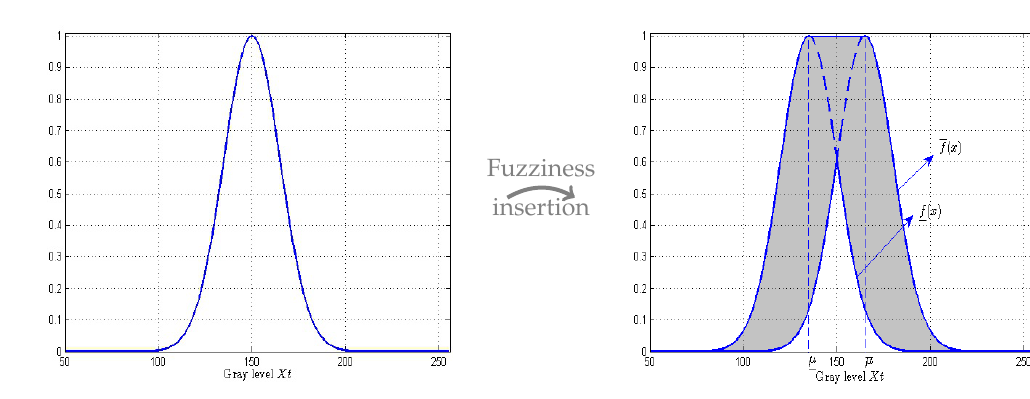
Figure 6. Fuzzy insertion into a Gaussian